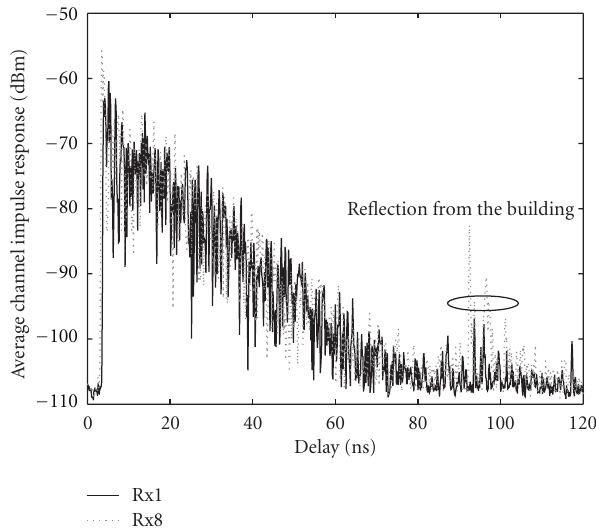
Figure 2: Average channel impulse responses for the UWB band in scenario 1: without a driver, when the engine is o ff . The positions of Rx antenna are Rx1 and